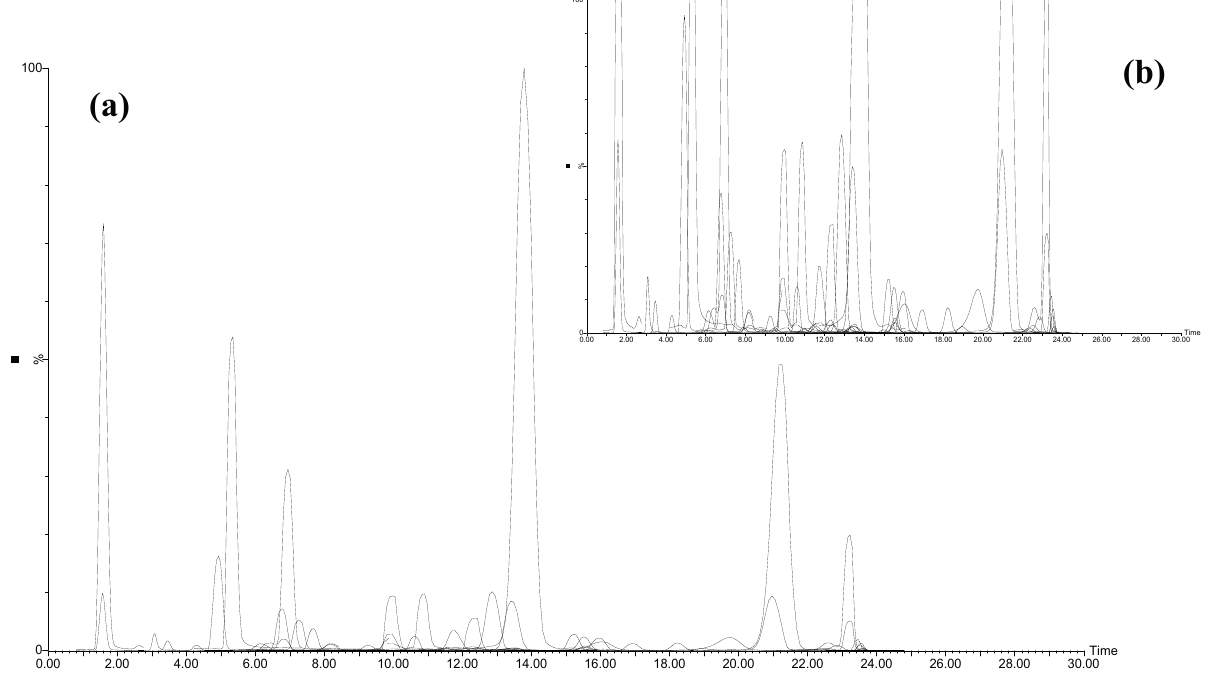
Figure 1. Superimposition of MRM traces from the UHPLC-QqQ-MS analysis of a rosé wine, ( a ) full display; ( b ) six-time zoomed